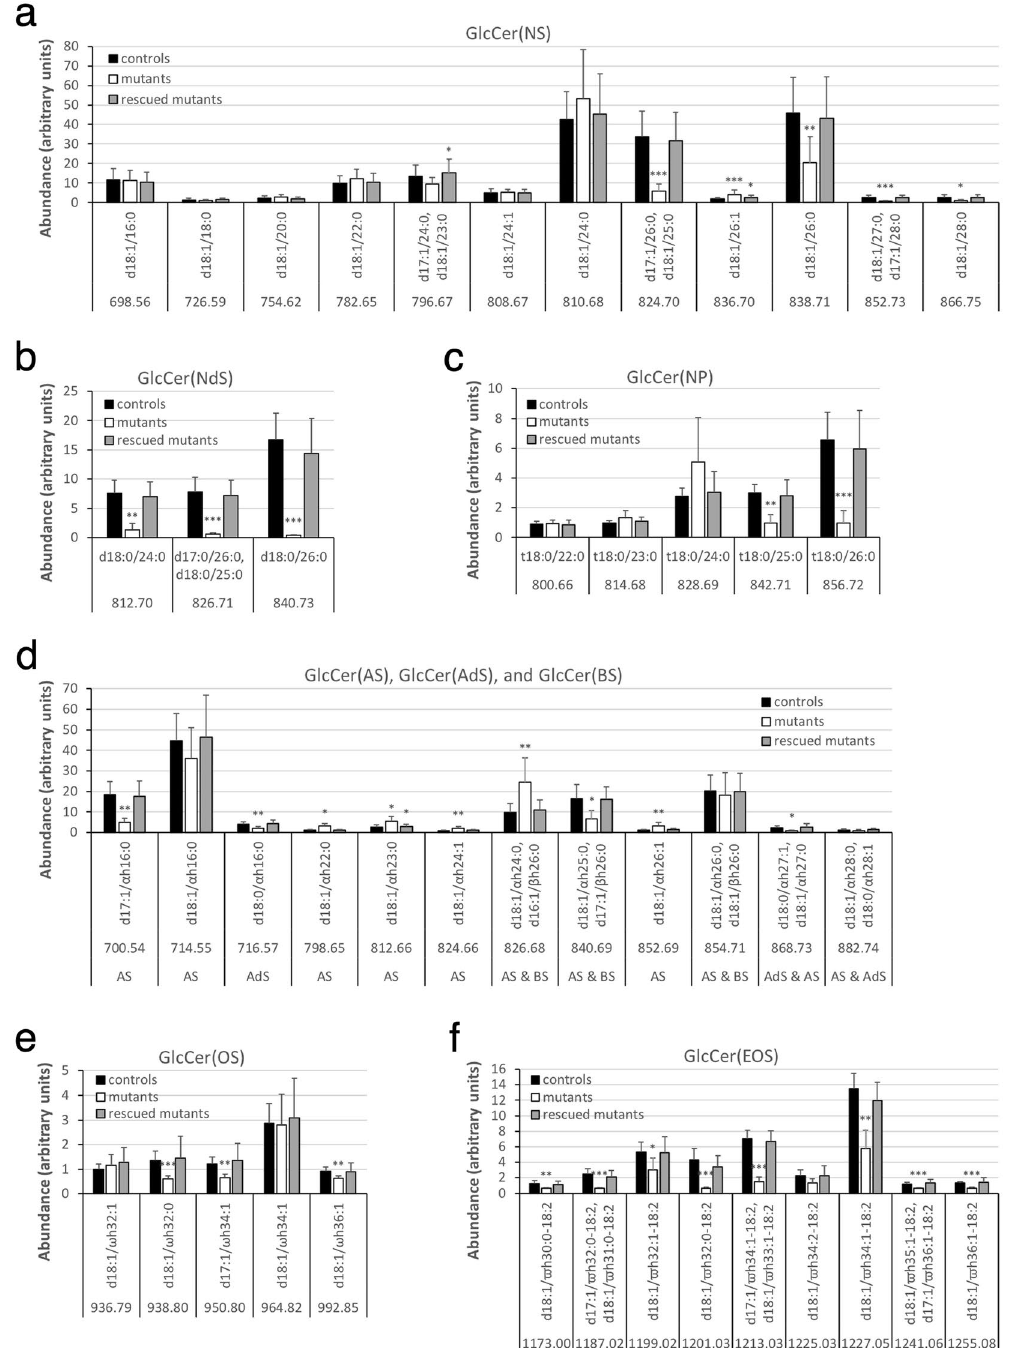
Figure 9. Alterations in GlcCer content in unbound epidermal lipids in Fatp4 − / − mice. Fraction 6 of unbound epidermal lipids of newborn mice was analyzed by ESI-MS as [M − H] − ions in the negative-ion mode and quantified in arbitrary units. Fatp4 − / − mice showed decreased levels of the GlcCer(NS), GlcCer(NdS), and GlcCer(NP) species that contained a longer saturated acyl chain ( a , b , c ), of several GlcCer(OS) species ( e ), and of nearly all GlcCer(EOS) species ( f ), and increased levels of several GlcCer(AS) species ( d ). Almost all these defects were normalized by the Fatp1 transgene. Data were obtained from 5 each of Fatp4 + / − (controls), Fatp4 − / − , and FATP1-rescued mutants with m/z ratios, standard deviation, and statistical significance shown ( * P < 0.05; ** P < 0.01; *** P < 0.001). See Materials and Methods for